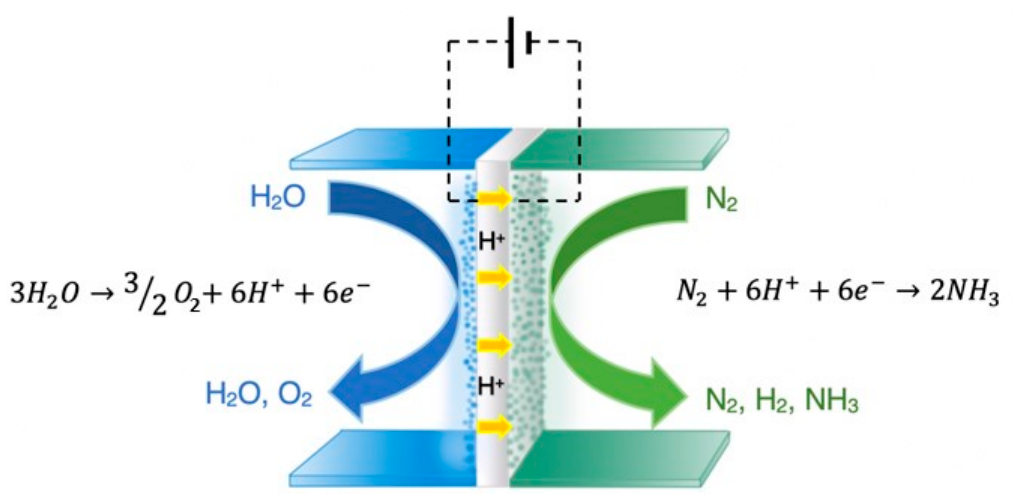
Figure 2. Schematic diagram of a solid state H + conducting cell where NH 3 is produced from H 2 O (steam) and N 2 .